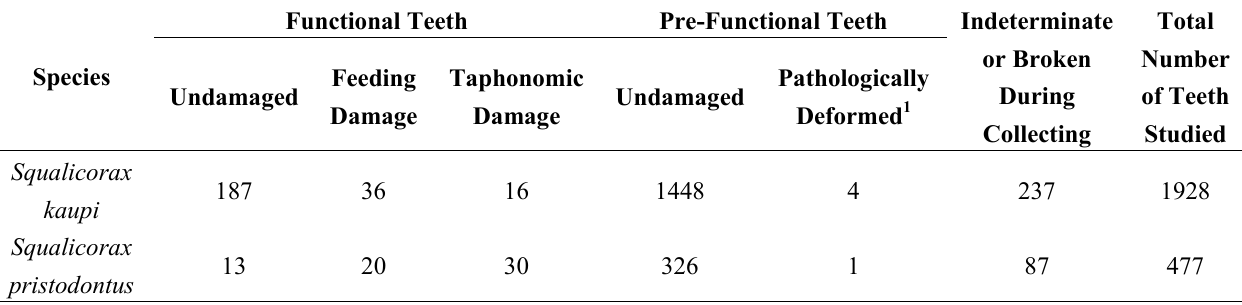
Table 1. Sample populations of S. kaupi and S. pristodontus functional and pre-functional teeth from the lowermost Navesink Formation. Individual teeth are designated as functional or pre-functional according to the degree of cusp and root development as described in the text.